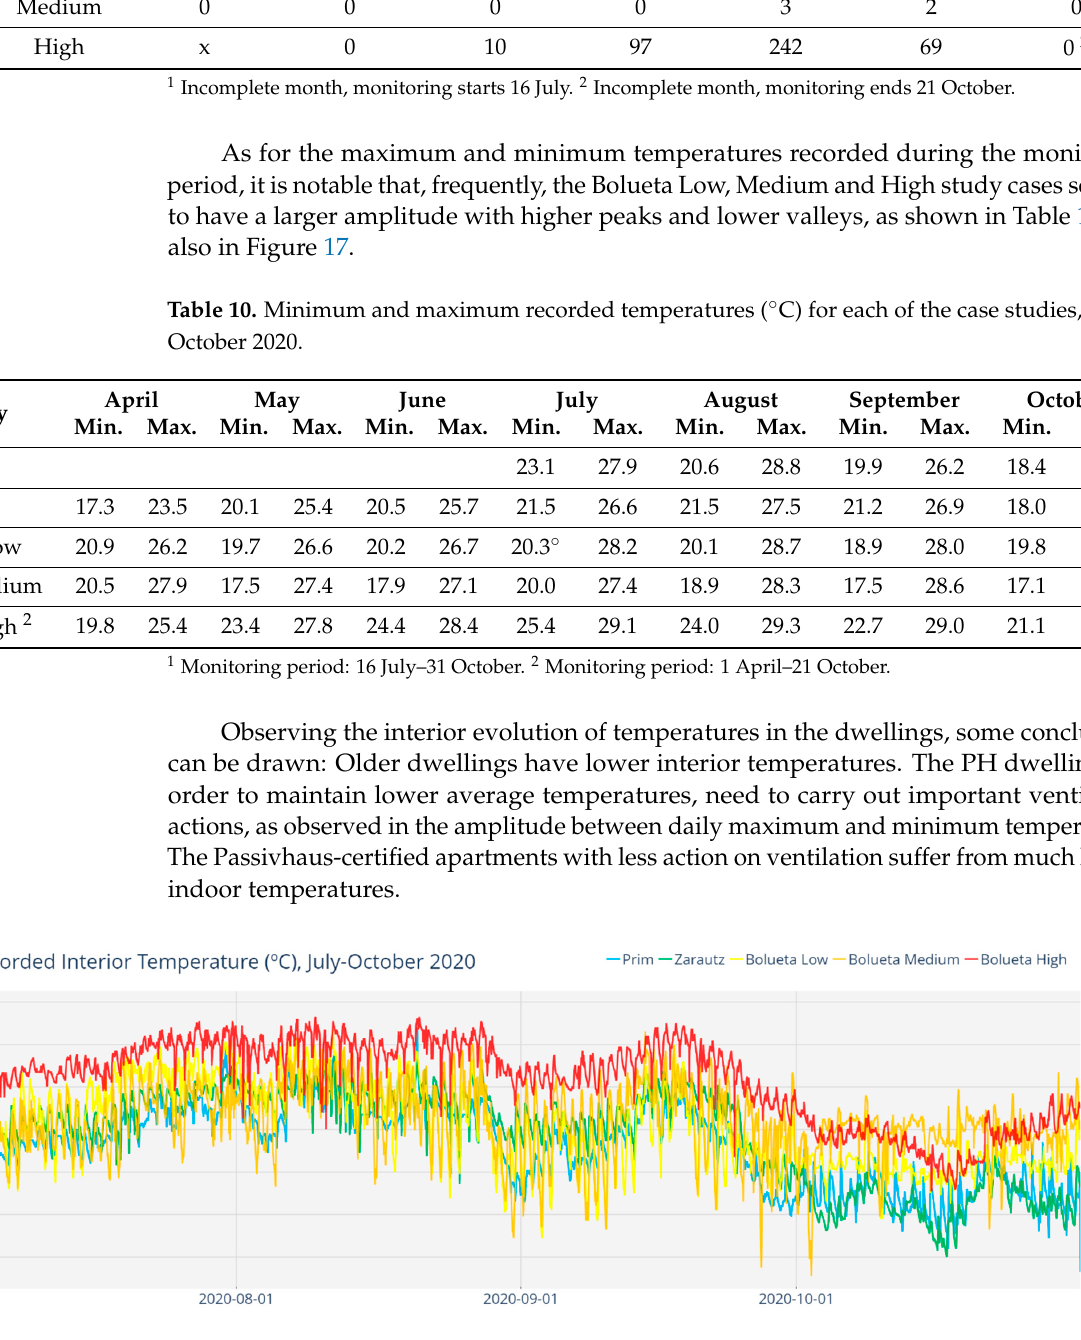
Figure 17. Recorded interior air temperature for all living rooms, 1 July to 31 October 2020. Source: